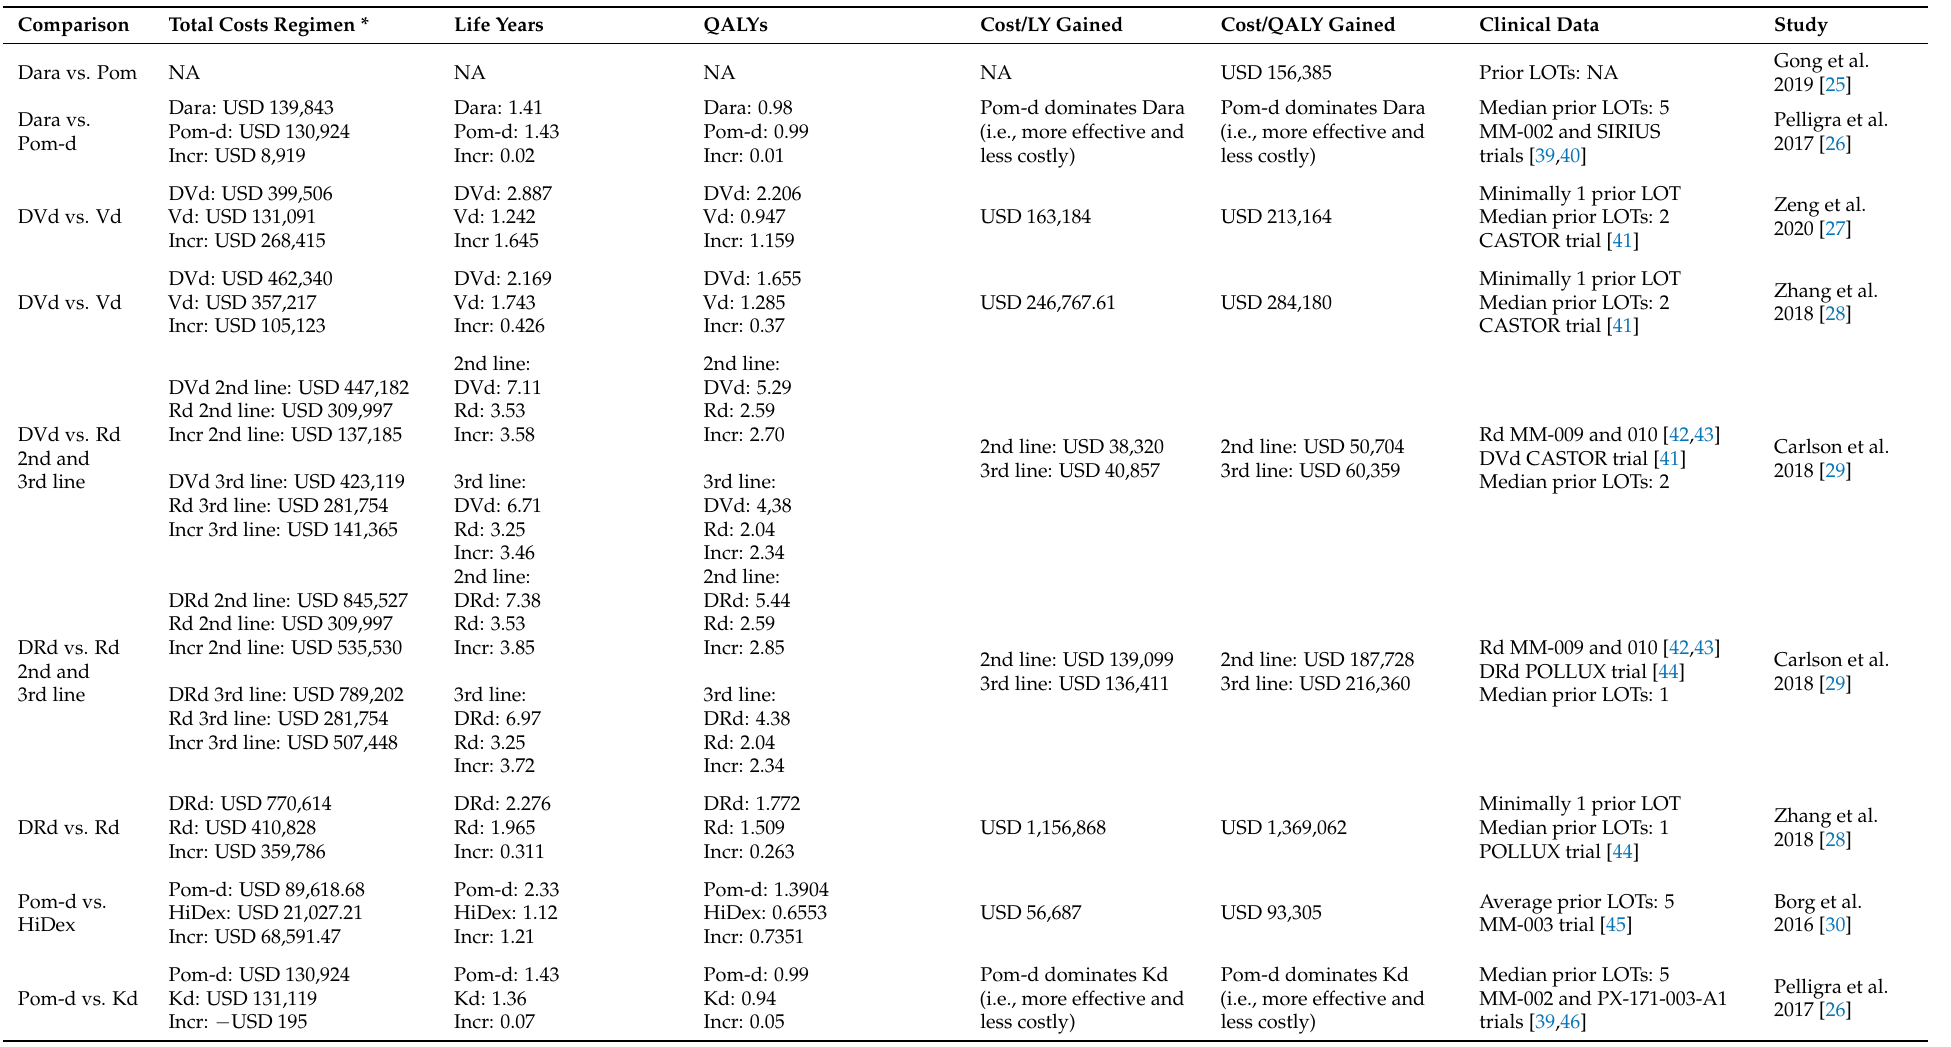
Table 2. Cost-effectiveness details of the comparisons in the included